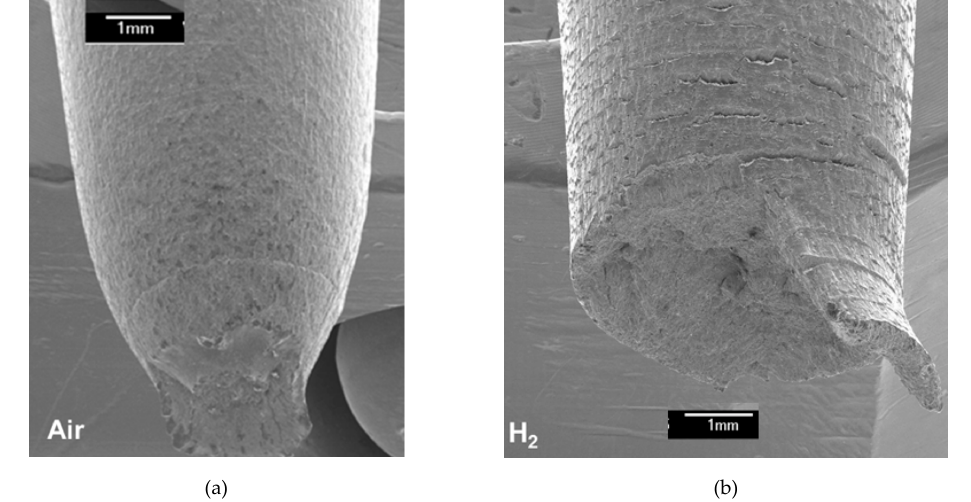
Figure 1 . ( a ) Cup and cone fracture and ( b ) flat fracture of a 316 SS when tested in air and 70 MPa of hydrogen, respectively.